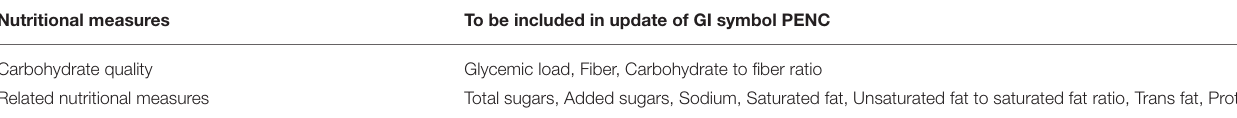
TABLE 2 | Summary of nutritional measures selected for inclusion in the updated PENC. Nutritional measures To be included in update of GI symbol PENC